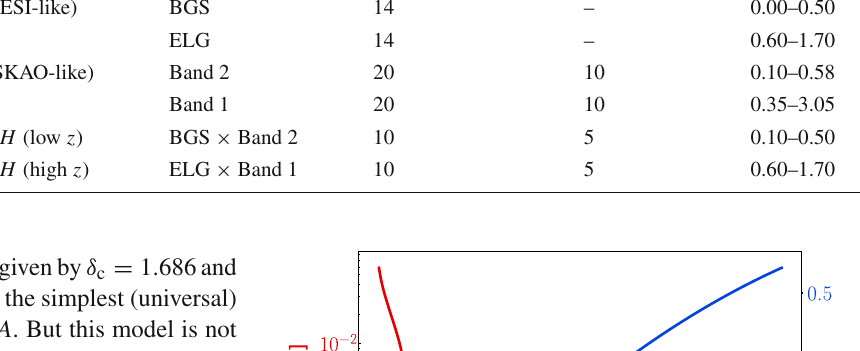
Table 1 Sky area and redshift range of surveys